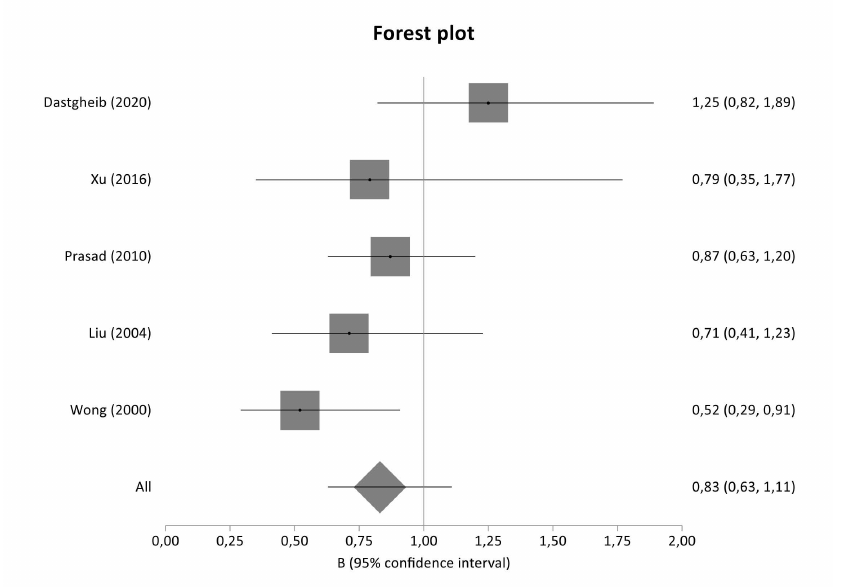
Figure 4. Forest plot of SERPINE1 4G/5G variant between diseased controls versus cases in T2DM subgroup